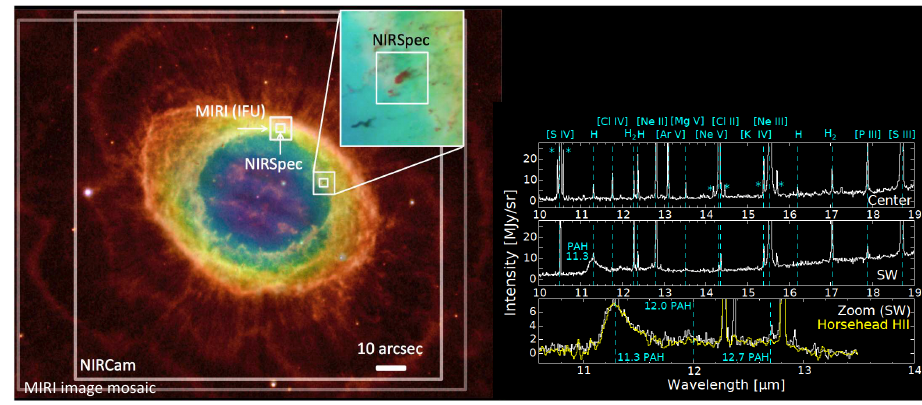
Figure 9. The PN, NGC 6720, ( left ) showing its knotty structure in a composite image combining optical imaging with HST in narrow emission-line filters F469N (HeII, purple), F502N (OIII, blue), and F658N (NII, green), and an LBT 2.12 µ m H 2 (red) image, together with various JWST instrument mode fields of view are superimposed (NIRSpec boxes represent IFUs); ( right ) Spitzer mid-IR spectra of two regions—near the center (top spectrum) and the main dust ring (middle spectrum), compared to that of the Horsehead Nebula (bottom spectrum), a well-studied PDR in the Orion Molecular Cloud complex with prominent PAH features (M. Matsuura, private